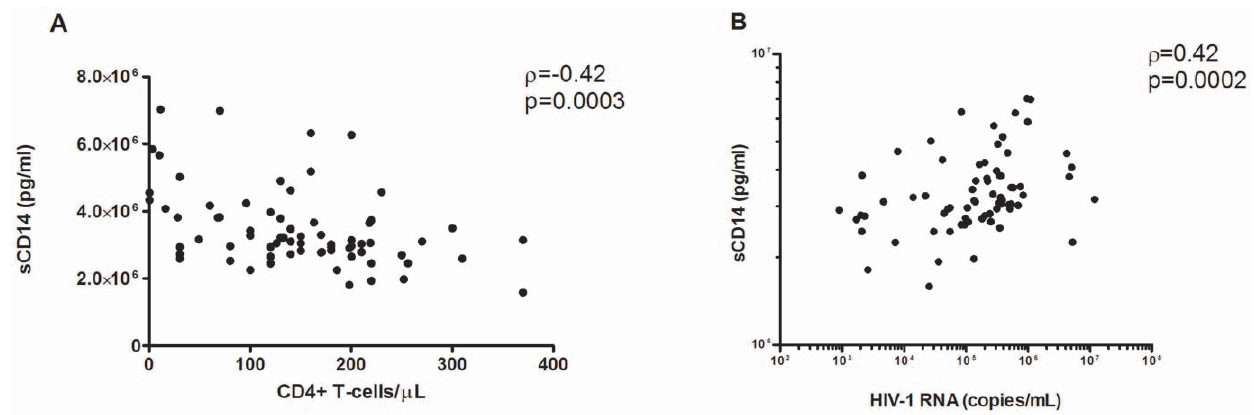
Figure 4. Correlations between sCD14, CD4 + T-cells and HIV-1 RNA. At baseline, significant correlations were found between sCD14 and CD4-T cell counts ( A ) or HIV-1 RNA viral load ( B ), respectively. Rho and p-value refer to Spearman’s rank